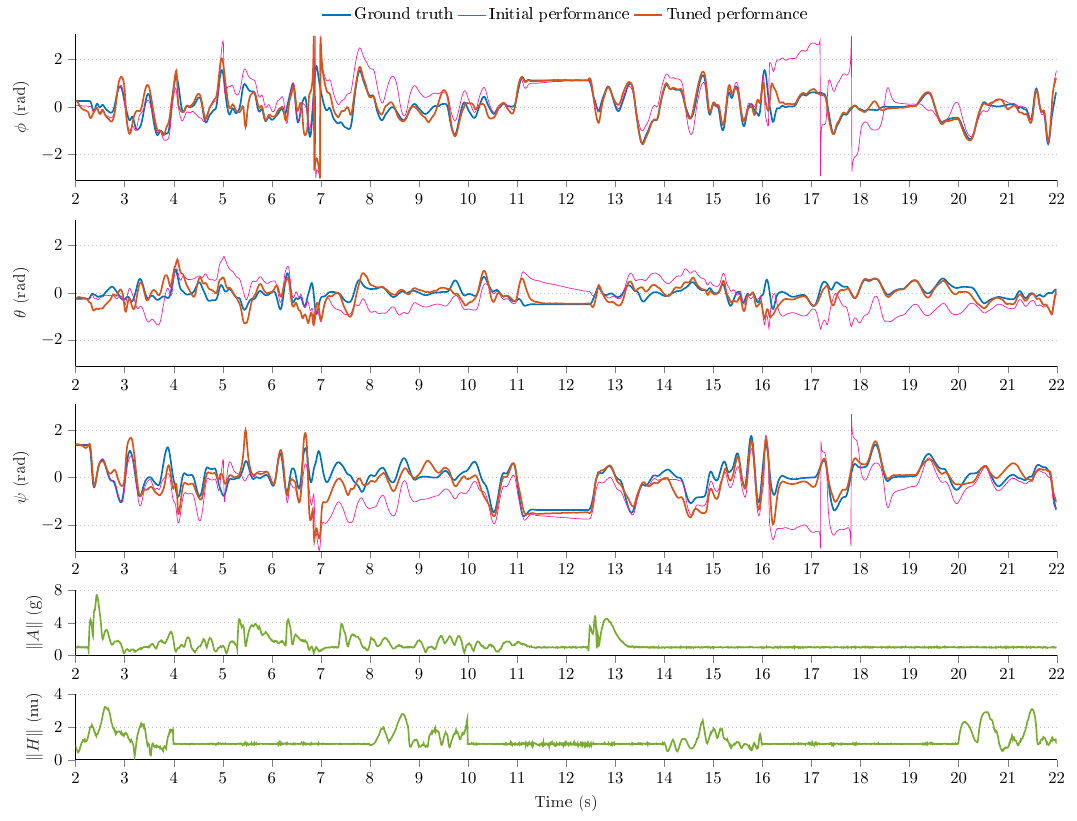
Figure 9. Initial and tuned performance of the explicit complementary